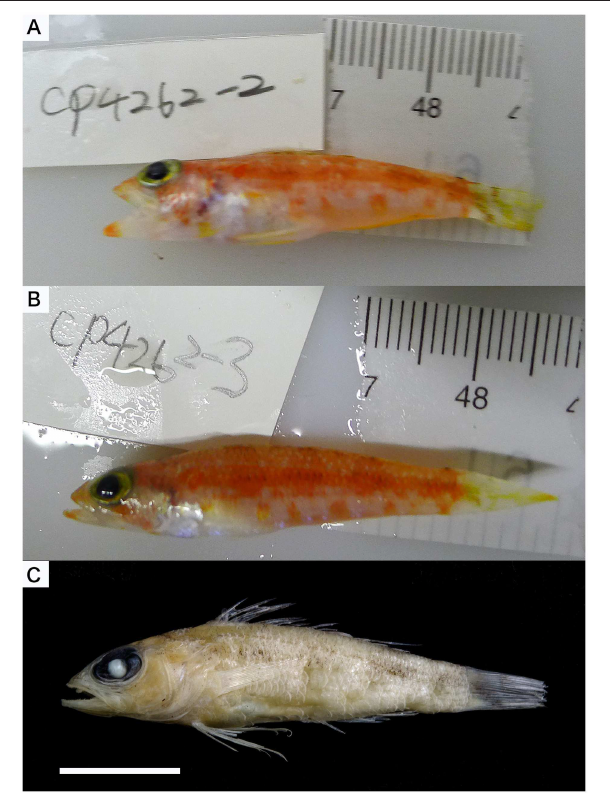
(A) NTUM15639 (PNG1830, holotype), collected on 25 Apr 2014; standard length 33.0mm (photographed by WJC-Lab); (B) NTUM15635 (PNG1831, paratype), collected on 25 Apr 2014; standard length 32.2mm (photographed by WJC-Lab); (C) same specimen in (A) , showing preserved pigmentation (photographed by MYL). Bars = 10mm.